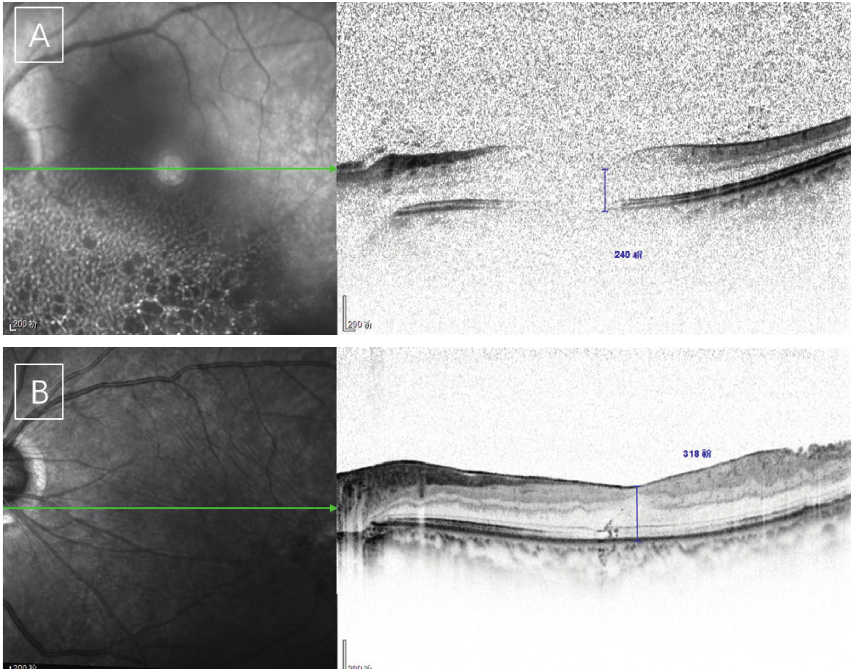
Figure 2: Spectral-domain optical coherence tomography scans of patients in the nonpeeling group. (a) Preoperative scan showing no epiretinal membrane. The scan is unclear because of vitreous hemorrhage. (b) A scan taken at the 35-day follow-up showing a macular pucker. A hyperreflective line at the foveal surface can also be clearly observed.